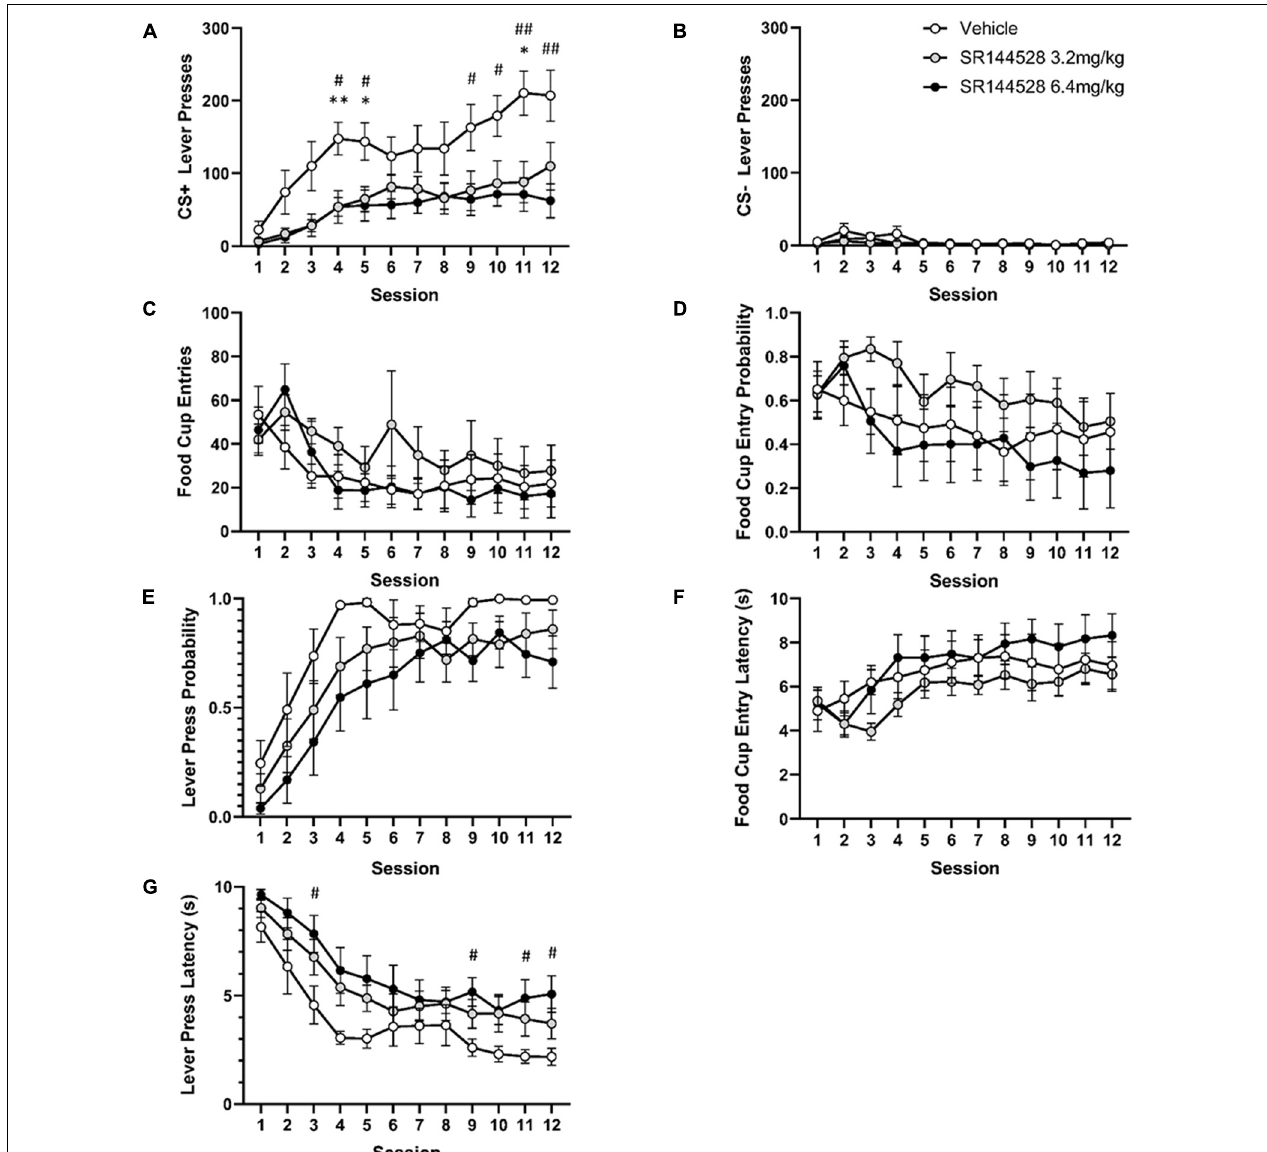
FIGURE 1 | Antagonism/inverse agonism of CB2R during adolescence modulates adulthood autoshaping task performance. (A) Mean lever presses on the CS+ lever. (B) Mean lever presses on the CS– lever. (C) Probability of a lever press at least once during its presentation. (D) Probability of entering the food cup during CS+ lever presentation. (E) Mean latency to press the CS+ lever. (F) Mean latency to food cup entry. (G) Mean cumulative food cup entries during CS+ lever presentation. * p < 0.05, ** p < 0.005 vehicle versus 3.2 mg/kg SR144528. # p < 0.05, ## p < 0.005 vehicle vs 6.4 mg/kg SR144528. Data presented as mean ±